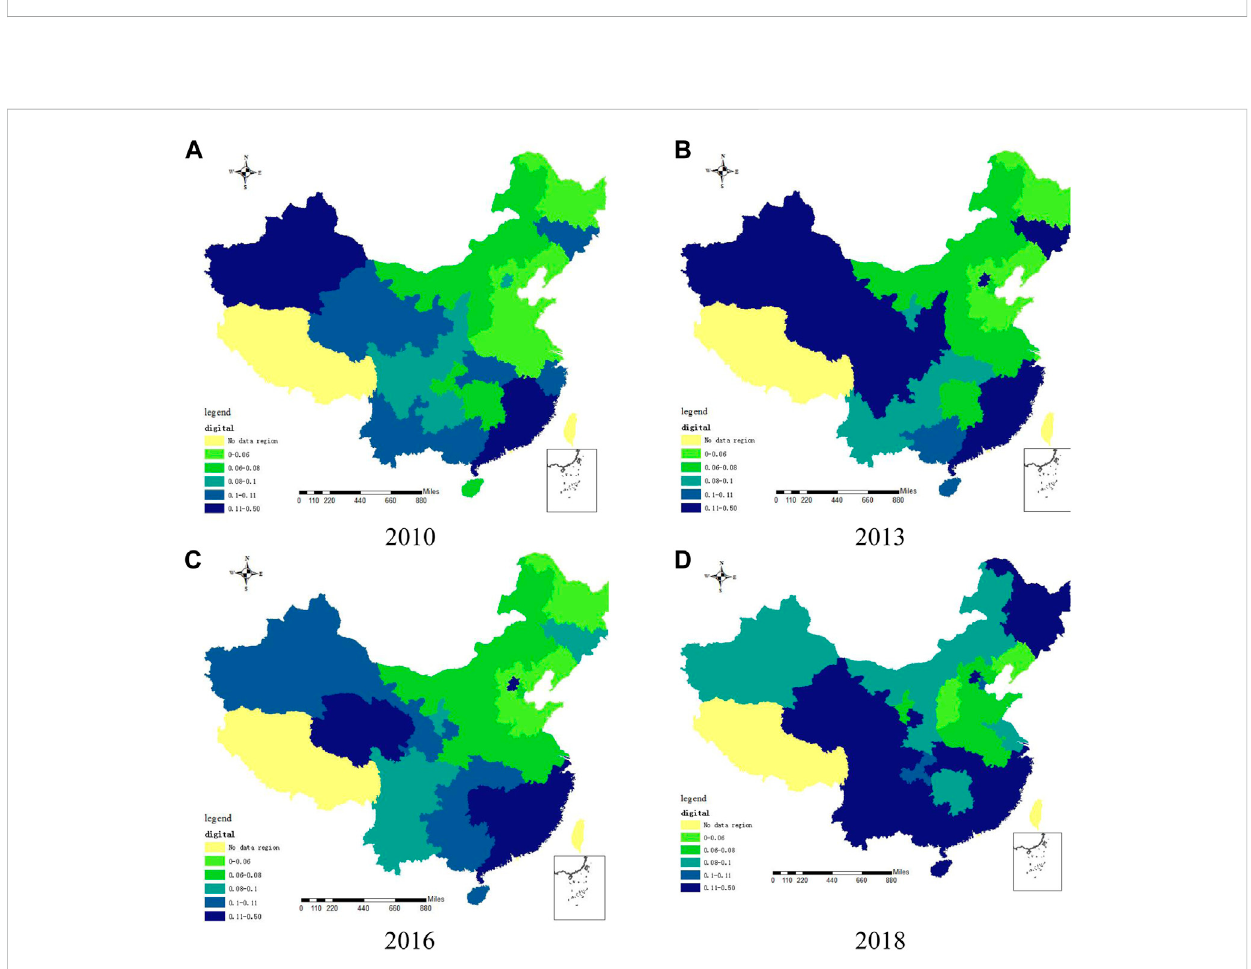
FIGURE 4 Spatial devolution of high-quality development level of green energy in China by region in 2010, 2013, 2016, and 2018. (A) : The high-quality developmentlevelofgreenenergyinChinabyregionin2010. (B) :Thehigh-qualitydevelopmentlevelofgreenenergyinChinabyregionin2013. (C) :The high-quality development level ofgreen energy inChina byregion in2016. (D) :The high-quality development level ofgreen energy inChina byregion in 2018.